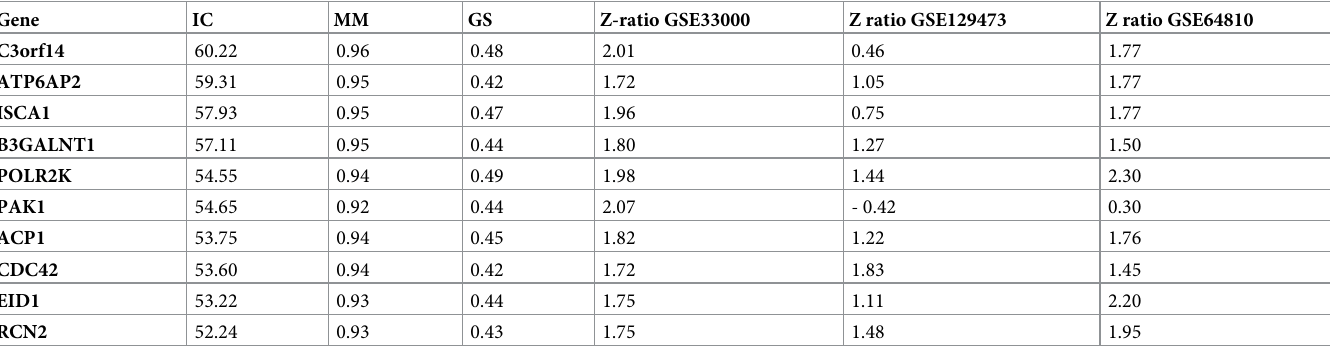
(Fig 3A) such as the Ras-related proteins 11A (RAB11A), 2A (RAB2A), 14 (RAB14), syntaxin- 7 (STX7), syntaxin-12 (STX12), or the sorting nexin 3 (SNX3) in M1. Among the three data- sets, the 41 proteins that belonged to M1 and function in protein transport processes showed a strong up-regulation in HD patient samples with a median Z-ratio of 1.51 (Fig 3B). To also include genes with lower Z-ratios into the functional enrichment analyses, irrespec- tive of their module membership, we additionally conducted gene set enrichment analysis (GSEA) of the three datasets independently. Strongly suggesting that the alteration of genes involved in protein transport may be relevant in HD, we found a strong enrichment of pro- teins involved in the co-translational protein targeting to the membrane in all three datasets by GSEA (Fig 3E). Additionally, genes functioning in cellular metabolic processes (GO:0044237, 56.3% of genes in M1 and FDR = 0.023), cellular respiration (GO:0045333, 3.4% of genes in M1 and FDR = 0.027) and translation (GO:0006412, 5.6% of genes in M1, and FDR = 0.023) were statistically significantly enriched in the M1 subnetwork. Similarly, when using the Reac- tome database, we observed a strong enrichment of proteins involved in protein metabolism, gene expression (transcription) and post-translational protein modification (Fig 3D). Using the network enrichment analysis test (NEAT), we found a highly statistically signifi- cant over-enrichment of 38 KEGG pathways in M1 (S3 File). Among these enriched pathways were “SNARE interaction in vesicular transport” (adjusted p-value = 1.74e-33), “RNA trans- port” (adjusted p-value = 2.10E-217), and “mRNA surveillance pathway” (adjusted p- value = 9.63E-60) (S3 File). 2.1.3. CDC42, PAK1, YWHAH and PPP2CA were identified as hubs in the M1 protein- protein interaction network. Highly connected nodes (hubs) are defined as genes or pro- teins with significantly more connections with other nodes in the network. The functional rel- evance of hubs has previously been demonstrated. Increasing the confidence in identified hubs, we analysed whether hubs identified by WGCNA are also hubs in the protein-protein interaction network (constructed using STRING database) and co-expression networks. As a hub gene of the WGCNA meta-module M1 with high intramodular connectivity, gene significance and module membership (Table 2 and S4 File), we identified CDC42 (Z-ratios: small GTPase that interacts with several effector proteins and thereby regulates cell migration [29], the bipolar attachment of spindle microtubules to kinetochores [30], the extension and Table 2. Top ten hub genes of meta-module